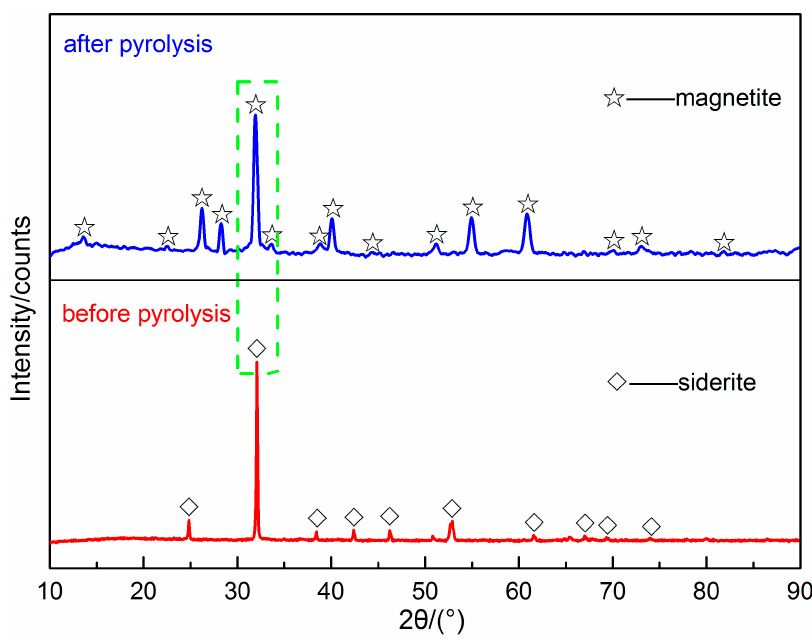
Figure 6. XRD patterns of the siderite before and after pyrolysis.